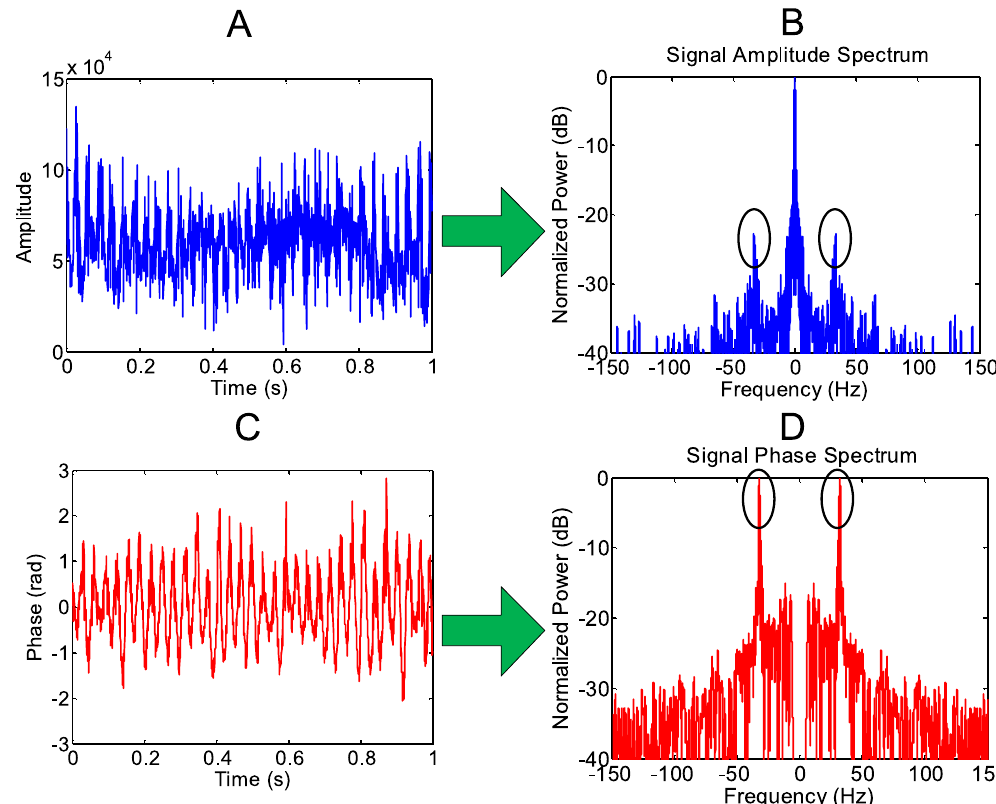
Figure 4. Wingbeat frequency extractions. The presented results are corresponding to Agrotis ypsilon (No.3) in W-band radar experiment. Both the extracted amplitude and phase modulations are shown in ( A ) and ( C ). Then Fourier transform is applied to measure wingbeat frequency as shown in ( B ) and ( D ), respectively. The black ellipses are used to mark the peaks that correspond to wingbeat frequencies.